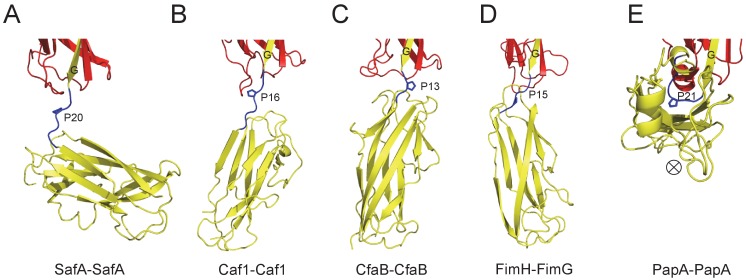
The Proline residue in LoopG-A controls the flexibility and overall architecture/shape of bacterial pilus.The structures of SafA-SafA in Salmonella atypical fimbriae (A), Caf1-Caf1 in Capsular F1 antigen pili (Zavialov et al., 2003) (B), CfaB-CfaB in Class 5 fimbriae (Li et al., 2009) (C), FimH-FimG in Type 1 pili (Geibel et al., 2013) (D), and PapA-PapA in P pili (Hospenthal et al., 2016) (E) are shown in cartoon representation. The preceding subunits are colored in red with the donor G strand in yellow. The following subunits are colored in yellow and the linker, LoopG-A, are shown in blue with the proline residues highlighted with stick representation. In order to visualize the flexibility between subunits, all the structures are superimposed based on the coordinates of the preceding subunit (red). ⊗ indicates an inward Z direction of PapA.